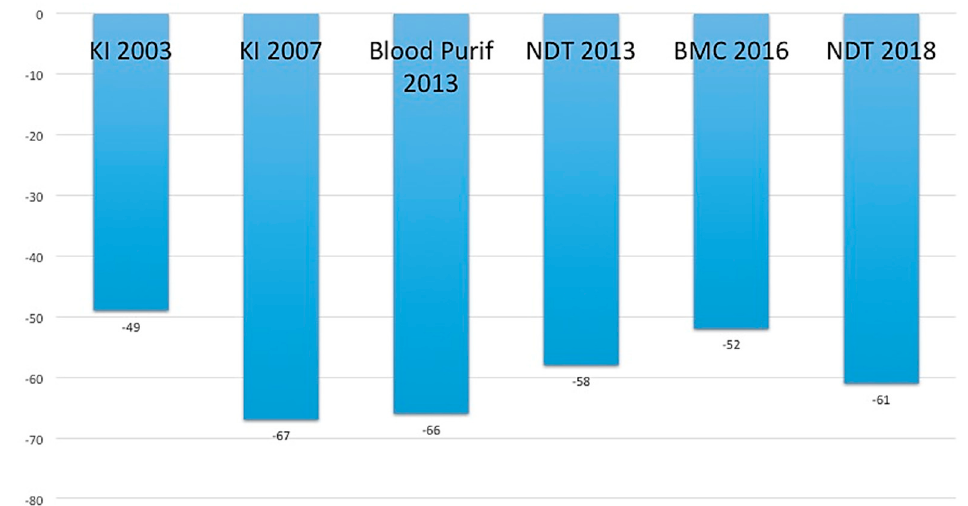
Figure 2. Urea reduction in several published studies. KI 2003 is reference number 12. KI 2007 is reference number 9. Blood Purification 2013 is reference number 31. NDT 2013 is reference number 41. BMC 2016 is reference number 20. NDT 2018 is reference number 17.